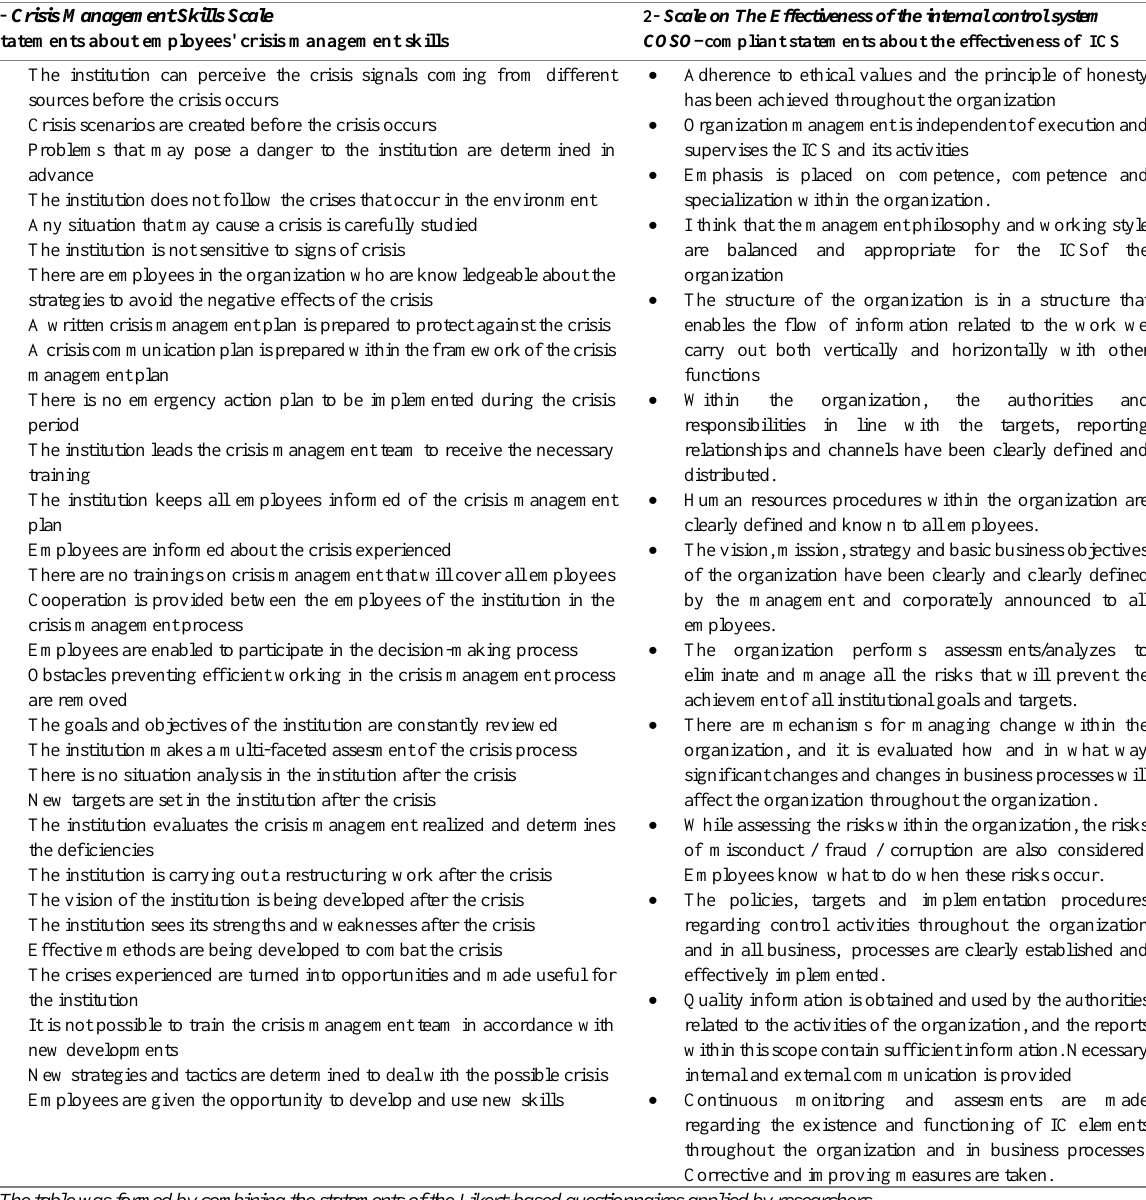
Table 2 : Statements in questionnaires applied in the study * 1- Crisis Management Skills Scale Statements about employees' crisis management skills